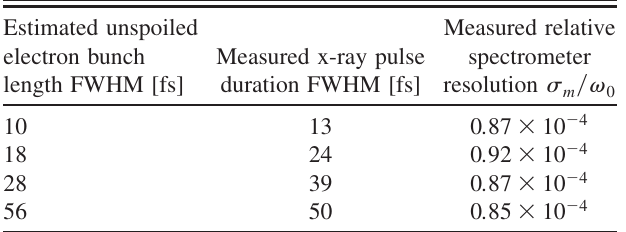
TABLE I. Electron bunch length controlled using the slotted foil and measured x-ray pulse duration as FWHM Gaussian. Electron bunch length is calculated with the formula presented in =! 0 is the relative spectrometer resolution measured for [21]. (cid:2) m each data